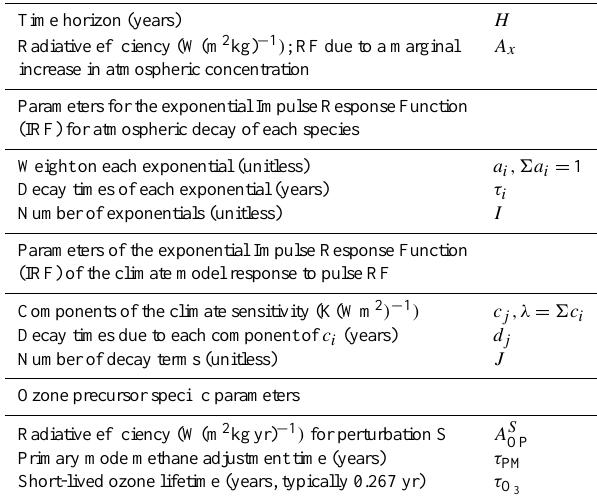
Table 1. Parameters used in the metric